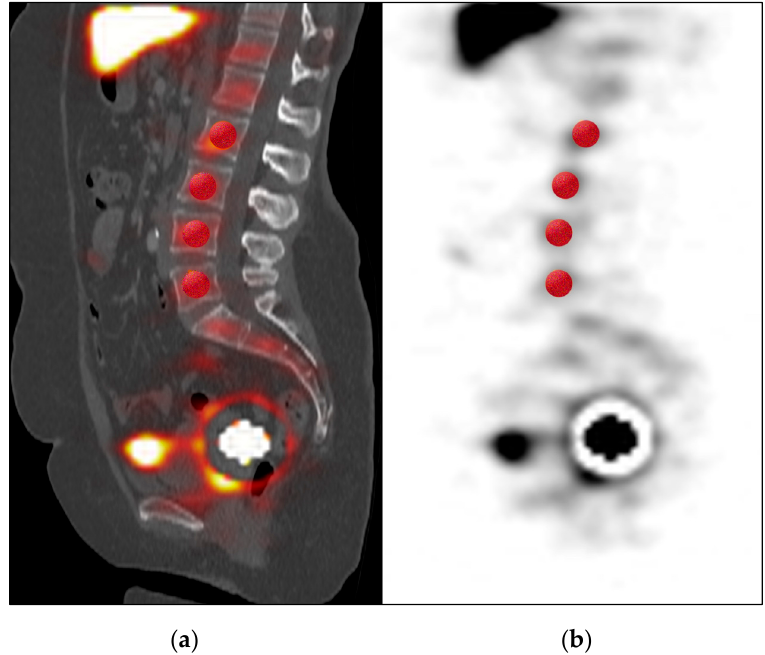
Figure 2. Spherical VOIs (red) placed in lumbar vertebrae (L2 to L5) shown in sagittal SPECT/CT ( a ) and SPECT ( b ) for bone marrow uptake measurement. Table 2. Parameters significantly affecting pre-operative SLN detection by SPECT/CT.